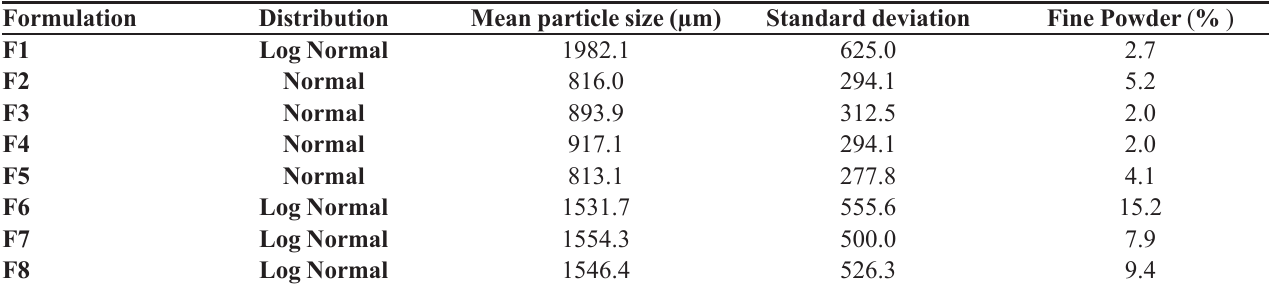
TABLE II - Mean particle size of Maytenus ilicifolia effervescent granules. Formulation